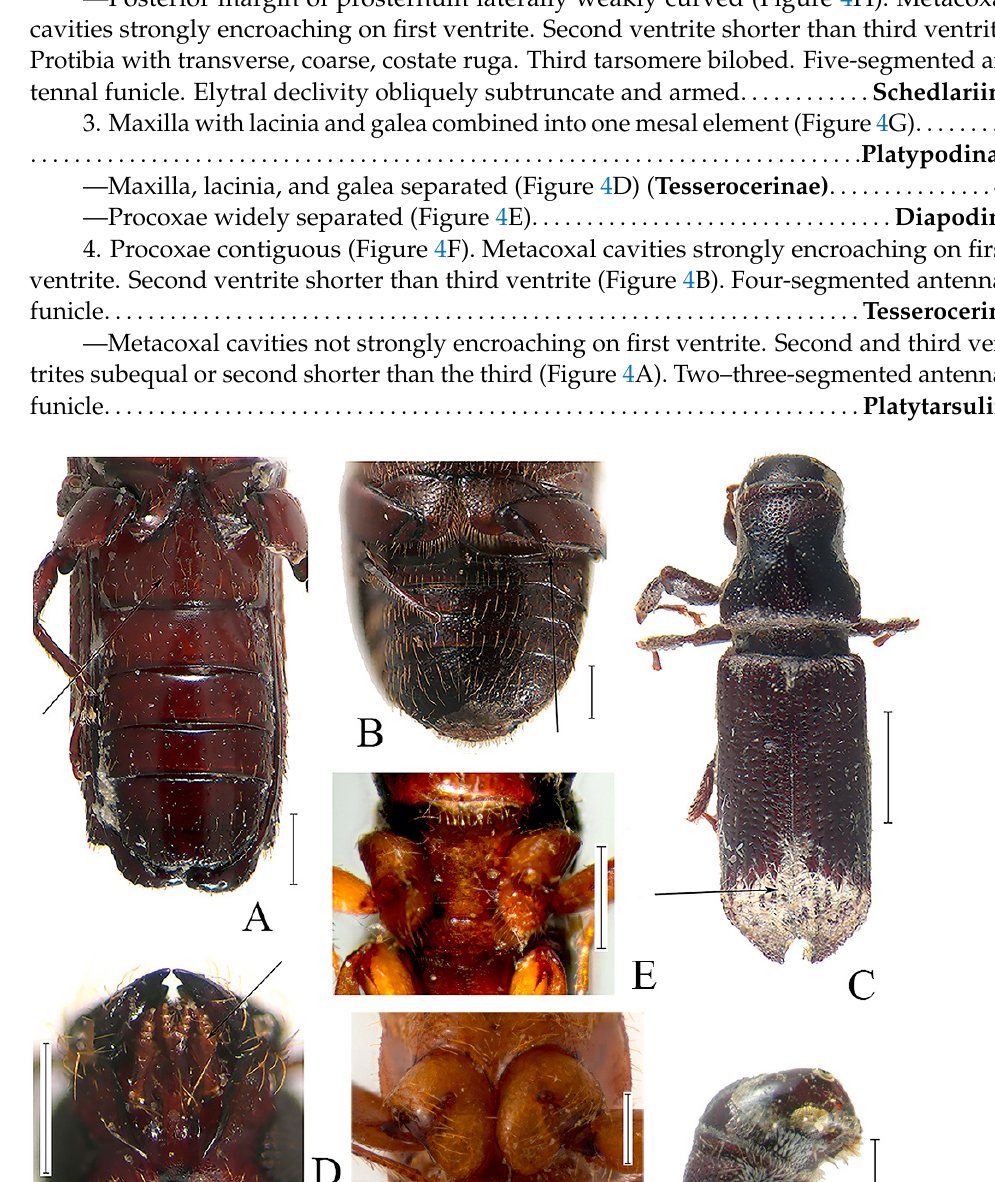
Figure 4. Platypodidae spp.: ( A ) Platytarsulus sp., abdomen, arrow shows first ventrite; ( B ) Crossotarsus sp., abdomen, arrow shows first ventrite; ( C ) Schedlarius mexicanus Dugès, 1886, habitus, dorsal view, arrow shows elytral declivity; ( D ) Platytarsulus sp., mouthpart, arrow shows maxilla; ( E ) Diapus sp., prosternum; ( F ) Tesserocerus sp., prosternum, arrow shows posterior margin; ( G ) Treptoplatypus severini Blandford, 1894, mouthpart, arrow shows mesal element; ( H ) Spathidicerus thomsoni Chapuis, 1865, prosternum, arrow shows posterior margin; ( I ) Schedlarius mexicanus , head and prosternum, lateral view, arrow shows elytral declivity. Scale bars 0.5 mm for ( A , B , D , F ), 1.0 mm for ( C , E , H , I ), 0.2 mm for ( G ).